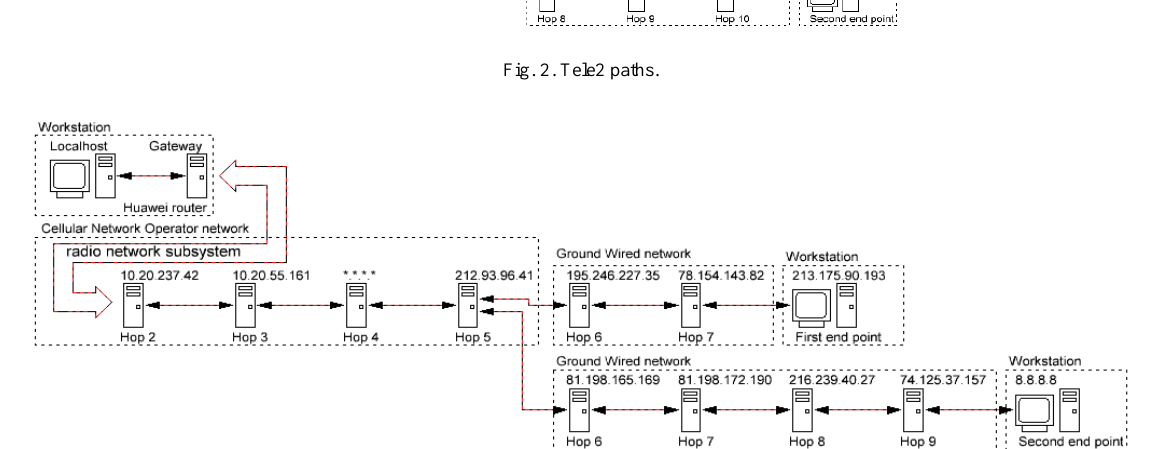
Fig. 2. Tele2 paths.